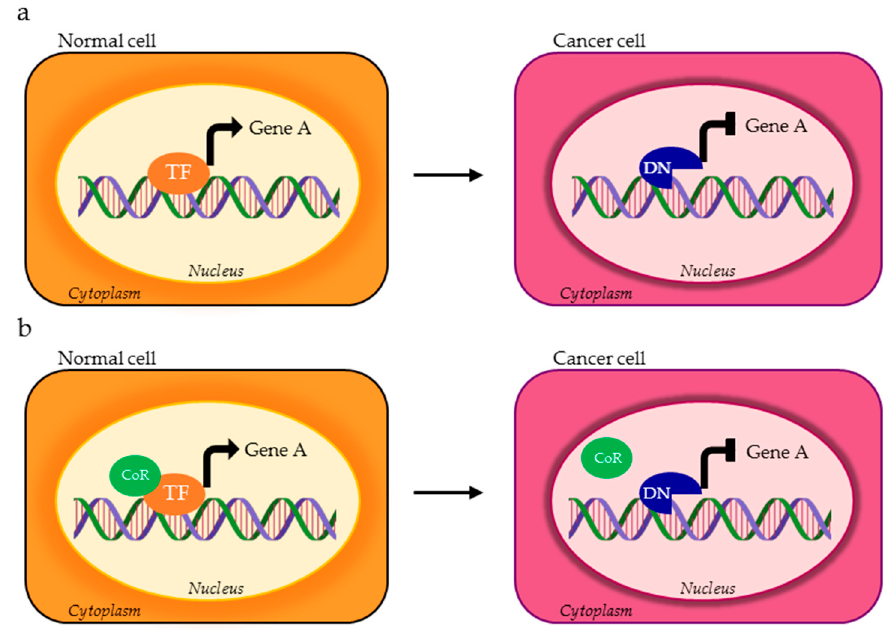
Figure 5. TF isoforms acting as DNs (blue DN) can preserve DNA binding to target genes but do not have transactivation or repressive potential because of ( a ) the loss of the TAD or repressive domain (RD) by AS or ( b ) impaired recruitment of transcriptional co-regulators (green CoR) necessary for proper transcriptional regulation.